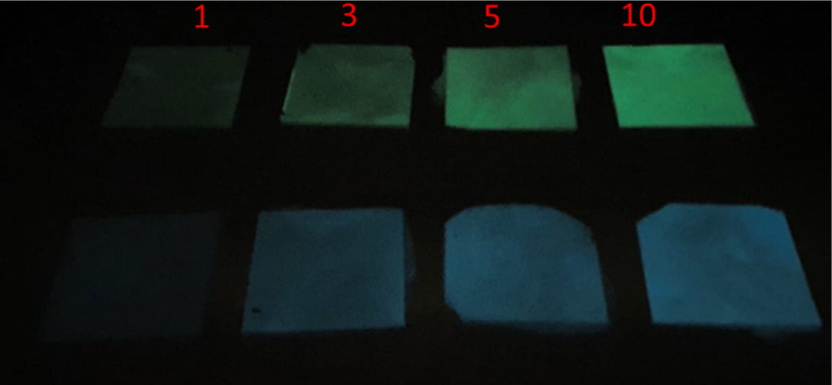
Figure 7. Phosphorescence emission under darkness; green for AG 1 composites and blue for AG 2 composites (1–10